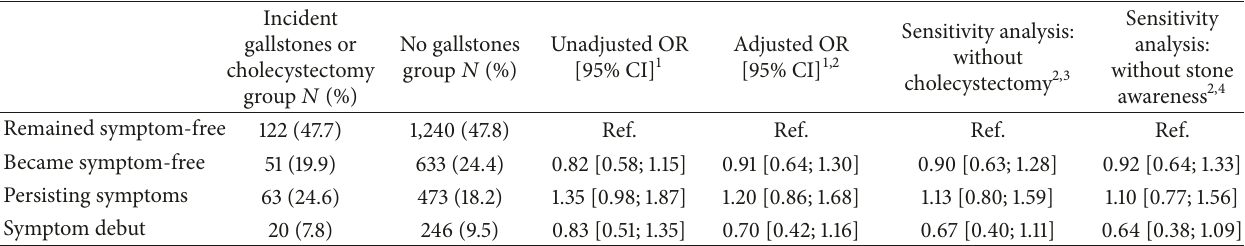
Table 2: Logistic regression analyses of changes in abdominal pain between baseline and follow-up in incident gallstone disease.